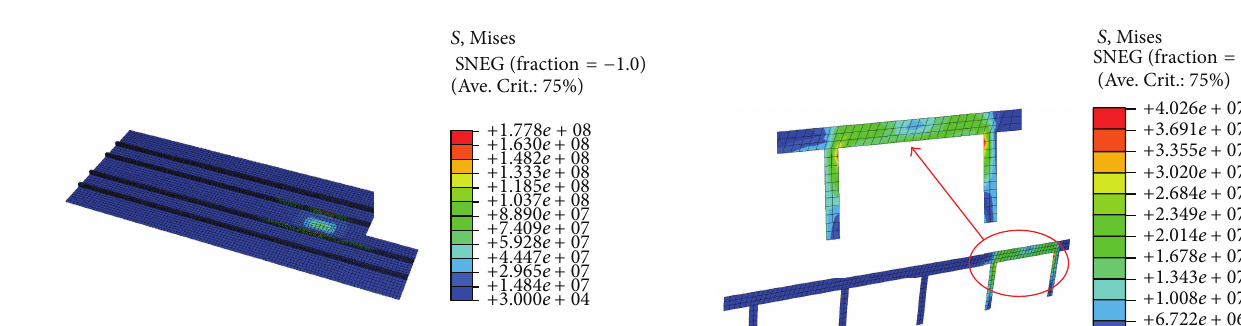
Figure 7: The von Mises stress (Pa) distribution in the slab and I- beam at level.